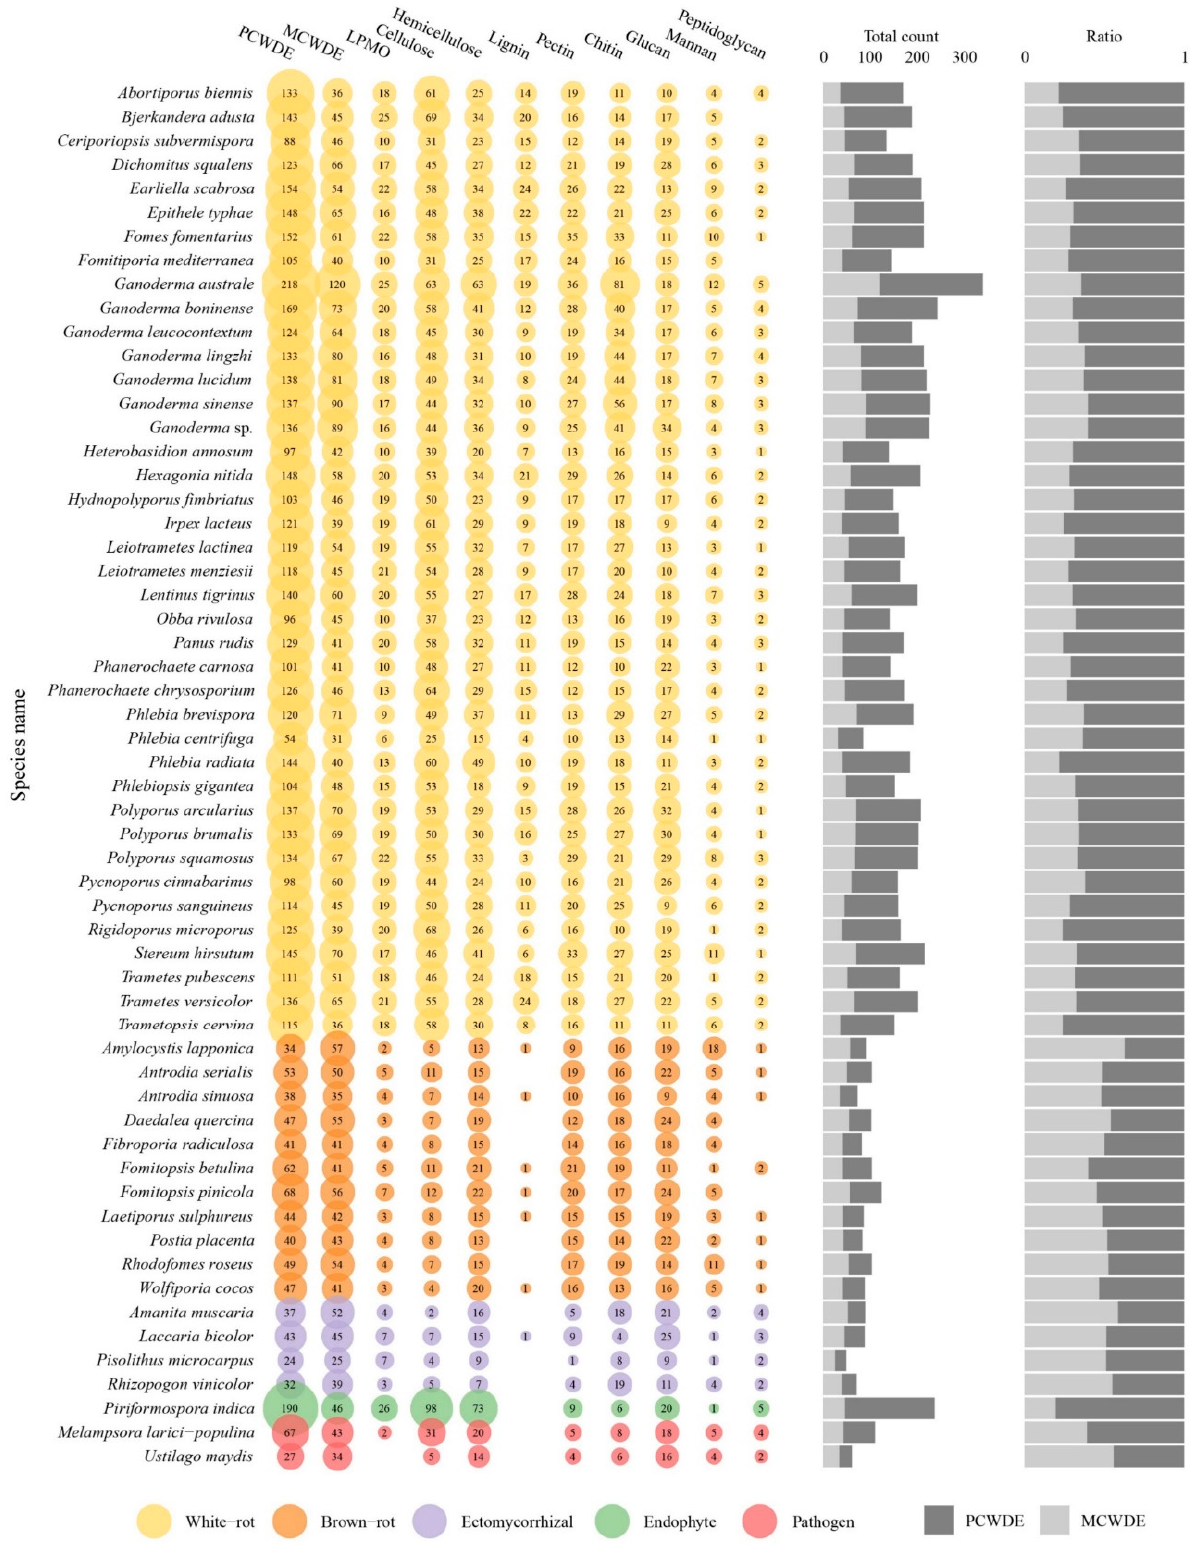
Figure 9. Distribution of secreted CAZymes involved in plant and microbial cell wall degradation in Ganoderma species and other selected fungal genomes. The bubble size is proportional to the number of secreted CAZymes grouped for 11 categories. Colors are coded by five lifestyles. The bar plots show the count of genes involved in PCWDE and MCWDE ( left ), and the ratio of PCWDE to MCWDE ( right ).